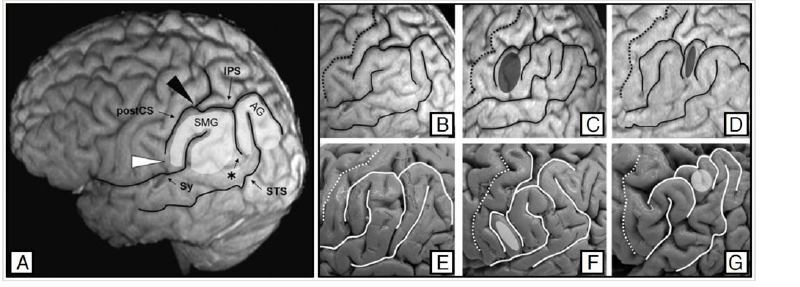
Example of natural morphological variability: left inferior parietal lobule (IPL; fi gure from [Kiriyama et al. 2009]). (A-D) are MRI data and (E-G) are post-mortem specimens. (A) IPL is highlighted and folds are outlined. (B,E) Typical folding pattern. (C,F) PreSMG pattern: an additional gyrus (ellipse) lies between postCS and SMG. (D,G) PreAG pattern: an additional gyrus (ellipse) lies between SMG and AG. [SMG: supramarginal gyrus; AG: angular gyrus; postCS: postcentral sulcus; IPS: intraparietal sulcus; Sy: Sylvian fi ssure, STS: superior temporal sulcus; *sulcus intermedius primus] postCS IPS * * Sy STS